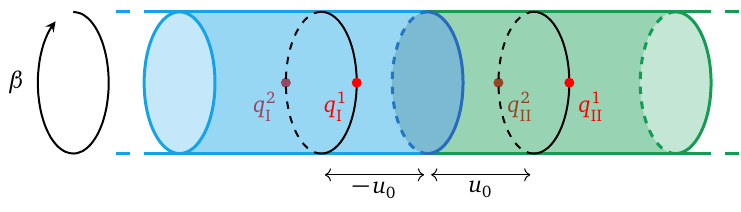
Figure 10: Thermofield double state of the system considered. The red dots are the twist operators. To obtain the Lorentzian evolution, one has to cut the cylinder at = 0 and v = i β v , and then perform the Wick rotation v E E 2